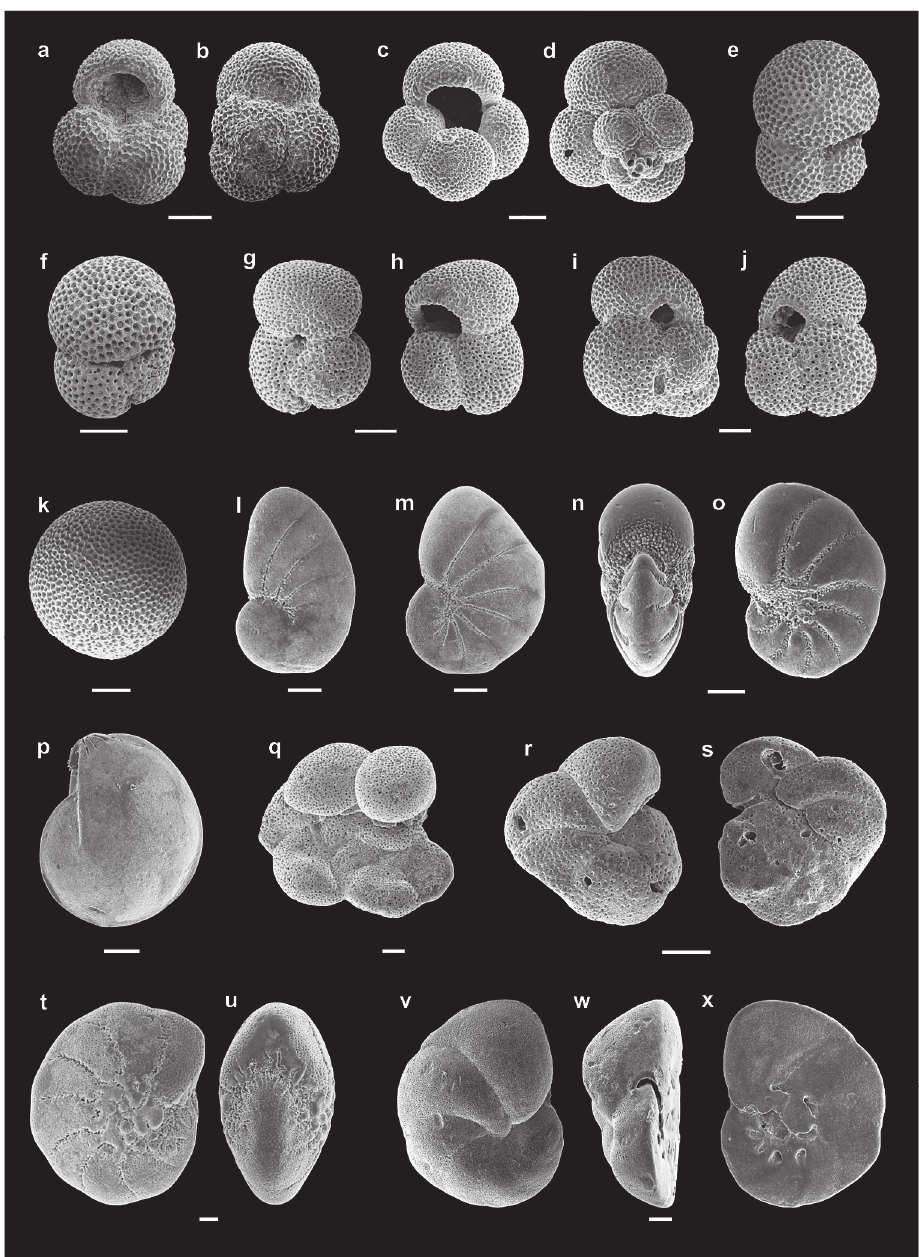
Fig. 5 - Selected foraminifera recorded from the well 2-TG-96-RS. ( a-b) Globoturborotalita apertura (a) umbilical view, (b) spiral view; (c-d) Globigerina bulloides (c) umbilical view, (d) spiral view; (e-f) Globigerinoides trilobus (e) umbilical view, (f) spiral view; ( g-h) Globigerinoides obliquus (g) umbilical view, (h) spiral view; ( i-j) Globigerinoides sacculifer (i) umbilical view, (j) spiral view; ( k) Orbulina suturalis ; ( l) Nonionoides grateloupi (spiral view); ( m-o) Nonionella atlantica (m) apertural view, (n) umbilical view, (o) spiral view; ( p) Lenticulina americana ; ( q) Dyocibicides bisserialis; ( r-s) Lobatula lobatula (r) umbilical view, (s) spiral view; (t-u) Elphidium excavatum (t) umbilical view, (u) spiral view; (v-x) Hanzawaia boueana (v) spiral view, (w) lateral view, (x) umbilical view . The scale bars represent 100